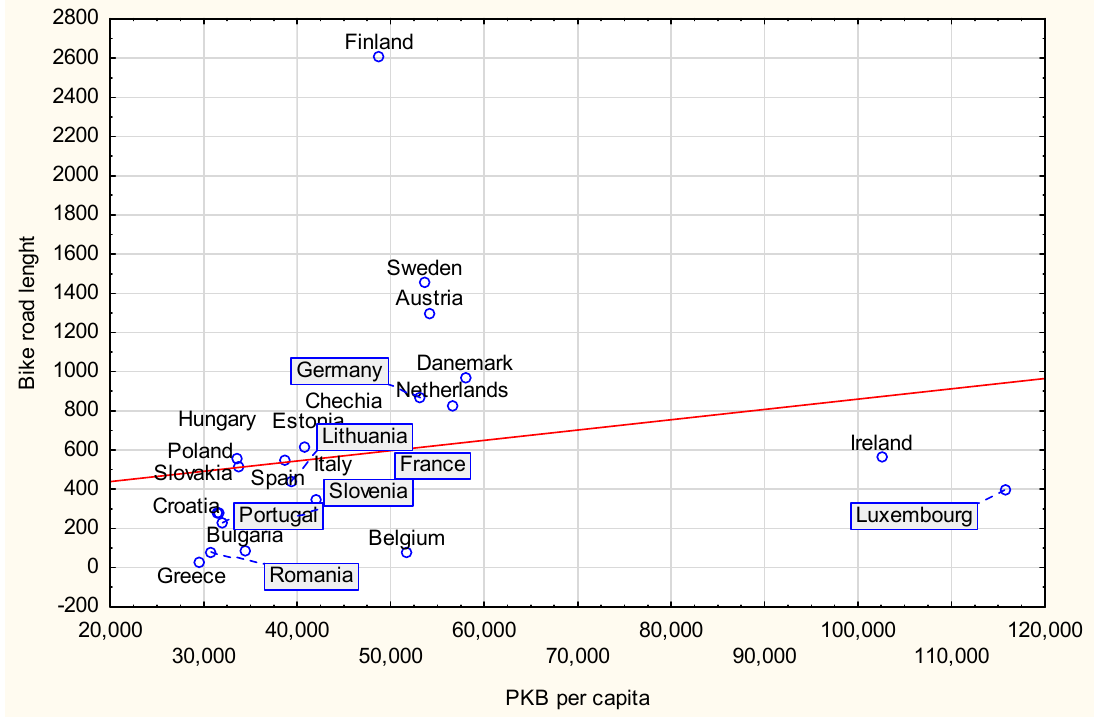
Figure 8. Scatter plot between GDP per capita and the average length of bicycle routes in smart cities. Source: author’s analysis.